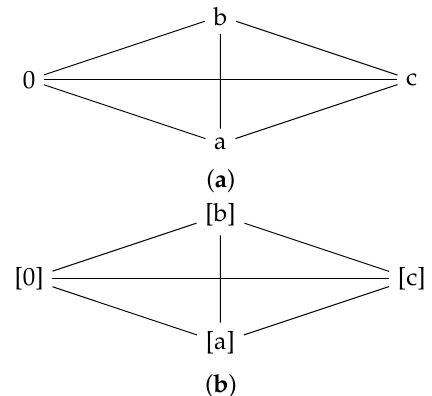
Figure 4. ( a ) Graph of G ( B ) ; ( b ) graph of G E ( B ) .